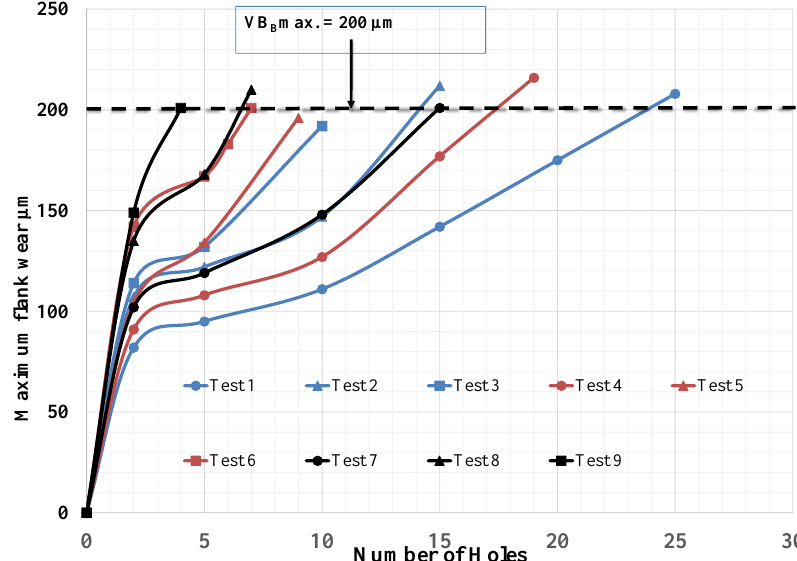
Figure 6. Flank wear against the number of holes for wiper (peripheral) insert.